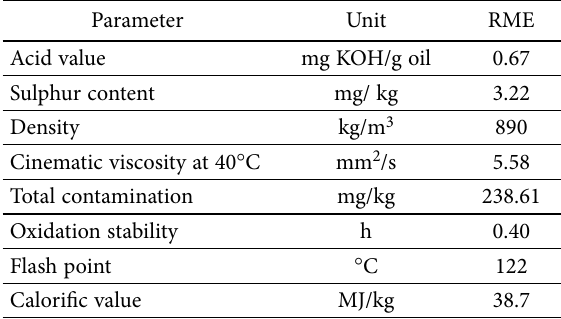
Table 1. Properties of RME